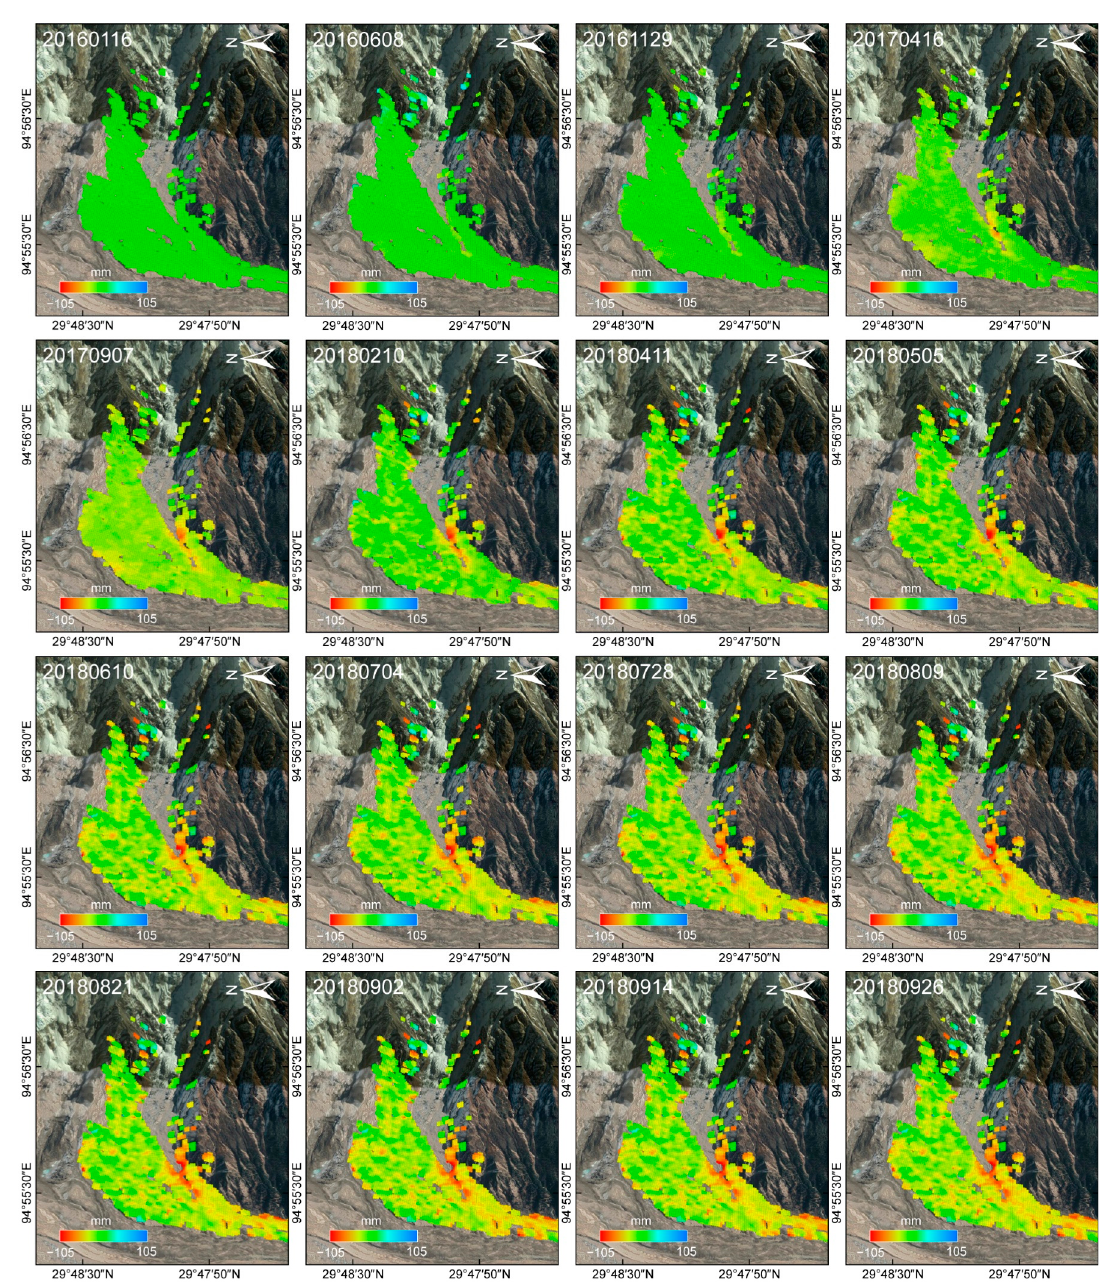
Figure 5. The cumulative deformation time series in the LOS direction for the source area where the first ice avalanche occurred in 2018 superimposed on Google Earth™ images. The first image was acquired in January 2016. The location of the ice avalanche source area was shown in Figure 3.